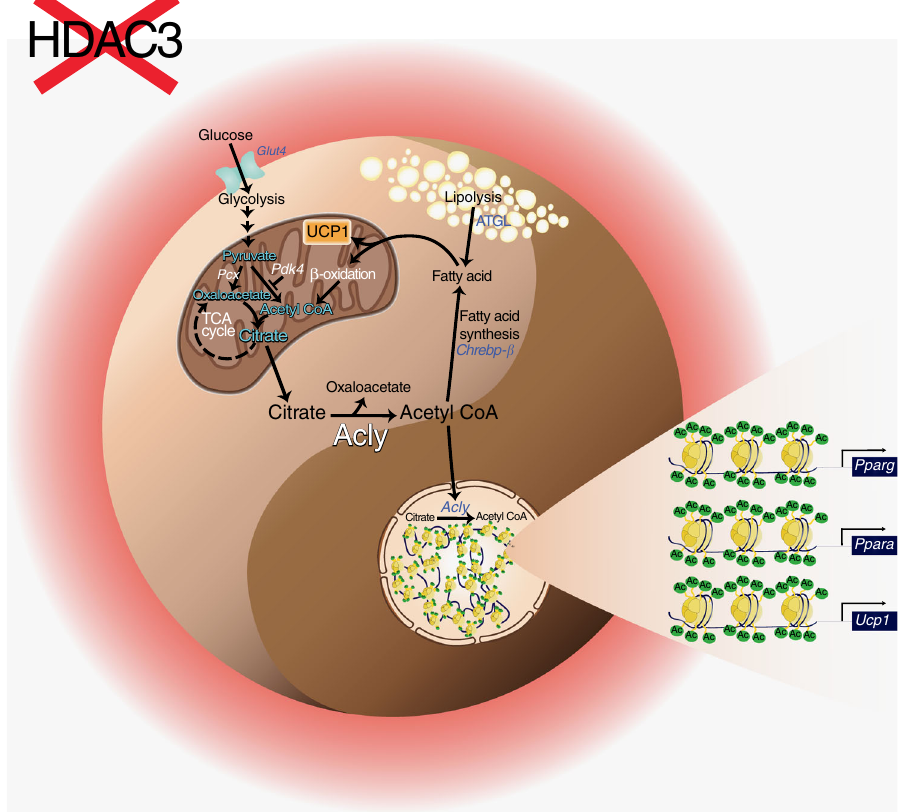
Fig. 9 Transcriptional and metabolic switch occurring in WAT of Hdac3 KO mice. Metabolism and epigenetic remodeling are complementary and mutually interconnected as each of these phenomena could in fl uence the other, giving rise to a speci fi c changes in cellular physiology. In our model, genetic ablation of the epigenetic modi fi er HDAC3 in WAT imposes a futile cycle of fatty acid utilization and synthesis that provides acetyl-CoA to remodel speci fi c chromatin regions, ultimately determining WAT browning. High-fat diet feeding perturbs this subtle equilibrium and prevents the epigenome remodeling required for rewiring metabolism in